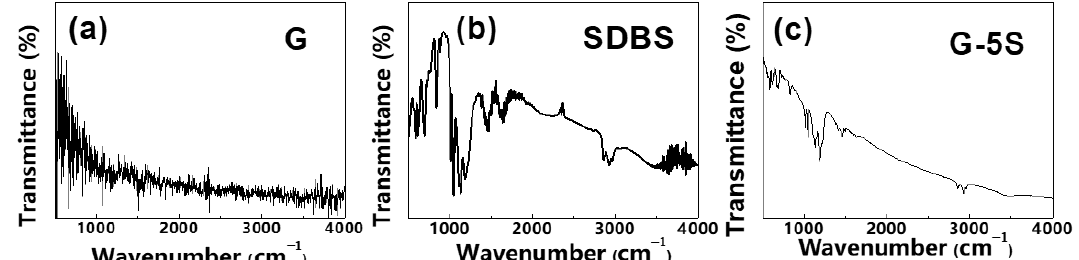
Figure 5. Fourier infrared spectrum of modified graphene samples: ( a ) G, ( b ) SDBS, and ( c ) G-5S.